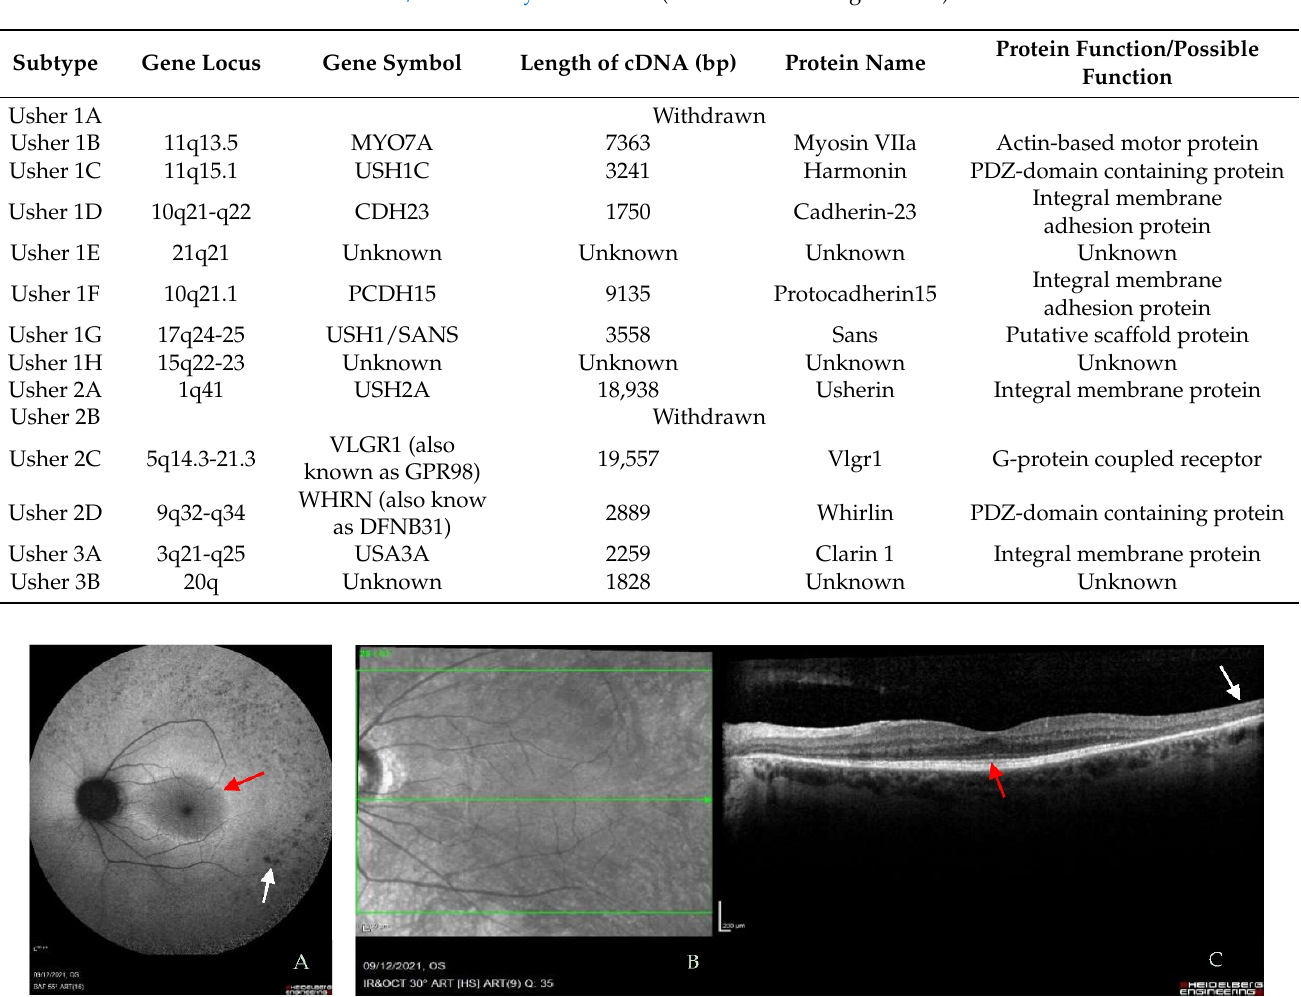
Table 1. Usher syndrome subtypes, genes and proteins. https://www.institut-vision.org/en/28 -diseases/91-usher-syndrom.html (accessed on 28 August 2022).